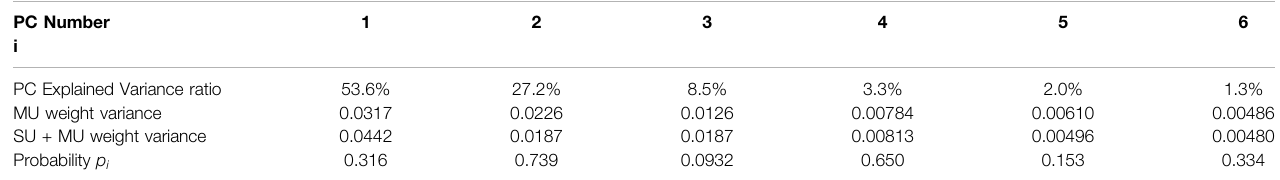
TABLE2| TheprobabilitiesassociatedwiththeseriesofK-S2-sampletestsperformedonthesetsofPCweights.TheK-StestisrepeatedforeachPCusedtoapproximate the pro fi le-differences from individual indentations and from the entire set. PC Number